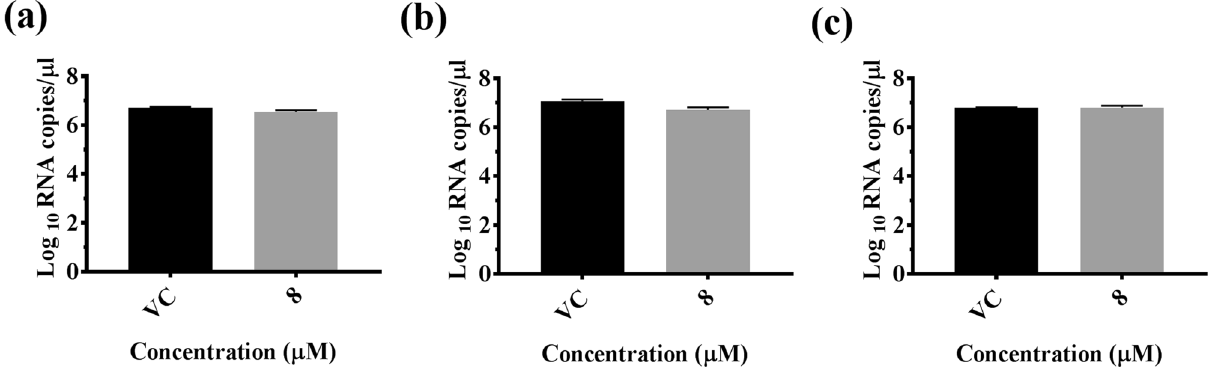
Figure 4. The effect of CA on CHIKV RNA levels in Vero cells, quantified by qRT-PCR under ( a ) pre- treatment, ( b ) co-treatment of virus with CA during infection, and ( c ) post-treatment conditions. The viral RNA titer was expressed as mean Log 10 viral RNA copies/µL ± SEM of three